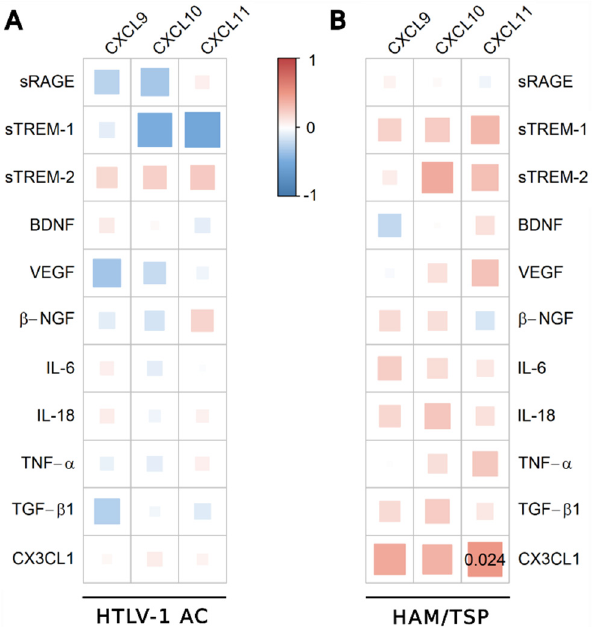
Figure 3. Correlation analysis between serum levels of inflammatory chemokines and factors associated with neuroinflammation. Correlation between serum levels of TGF- β 1, IL-18, BDNF, β -NGF, VEGF, sTREM-2, IL-6, sRAGE, TNF- α , CX3CL1 (fractalkine), sTREM-1, and chemokines (CXCL9, CXCL10, and CXCL11) was evaluated in ( A ) asymptomatic HTLV-1 carriers (AC) ( n = 13) and ( B ) HAM/TSP patients ( n = 20) using the Spearman’s rank correlation test. Correlation coefficients are indicated by color intensity, in which positive correlations are shown in red and negative correlations in blue. The size of the squares at intersections between factors represents the p -value, which is shown only for significant associations ( p < 0.05).